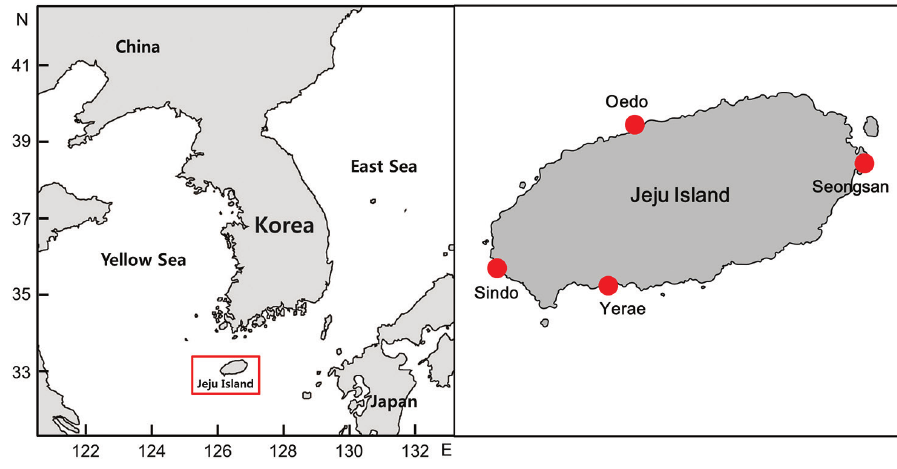
Figure 1. Map showing the location of Jeju Island and sampling sites.